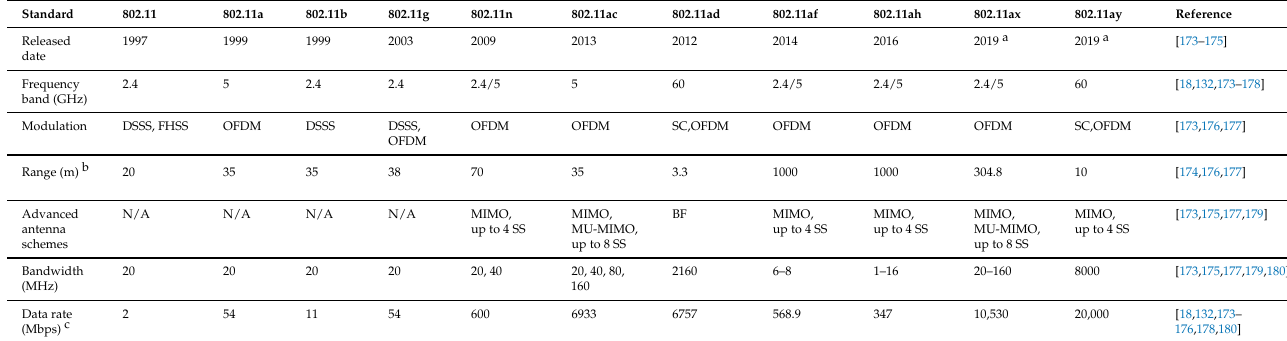
Table 4. IEEE 802.11 network PHY